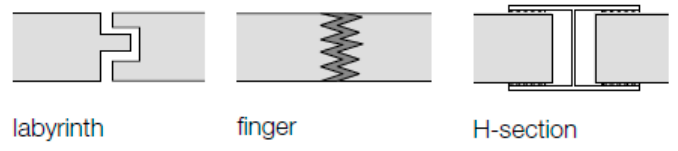
Figure 15. The joint principles which inspired the sliding seal solution [32].